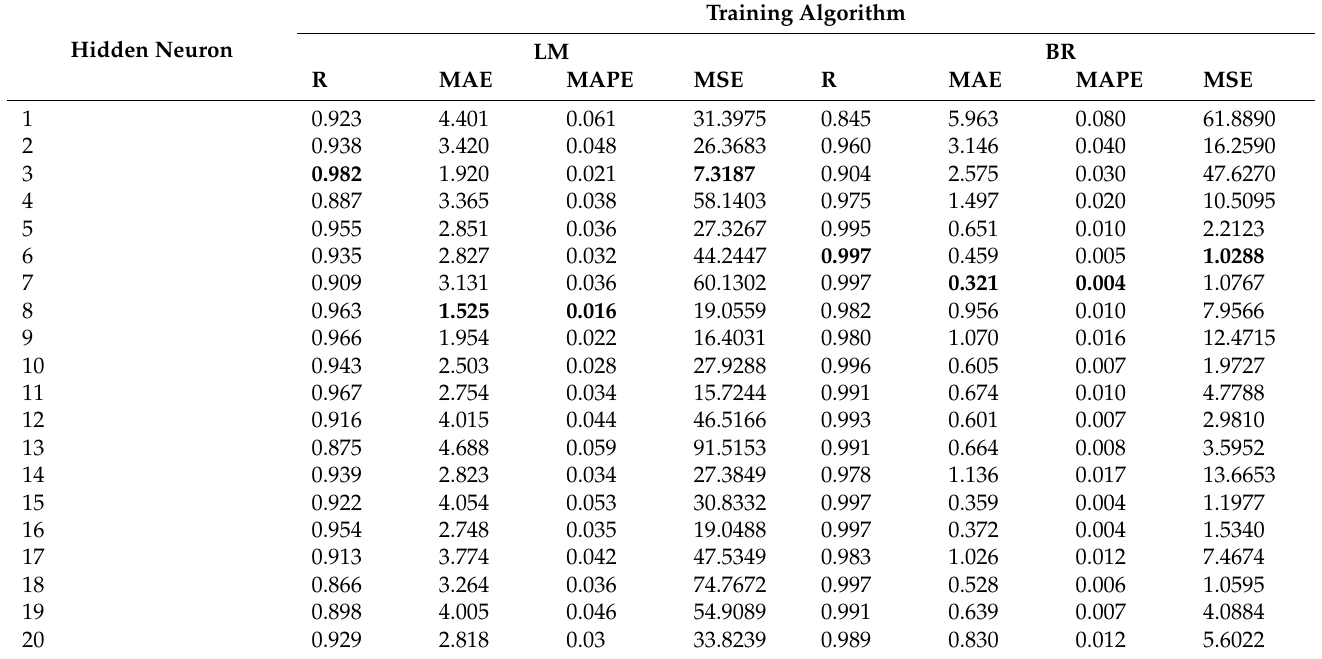
Table A19. R, MAE, MAPE, MSE value for COD removal for different training algorithms at different number of hidden neurons (aerobic process).